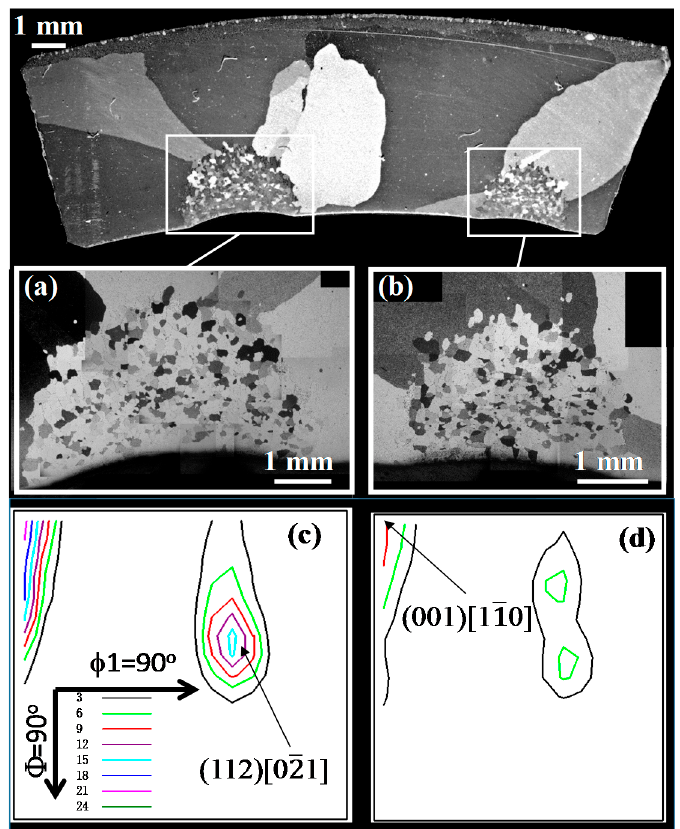
Figure 3. Recrystallized microstructure after annealing at 1350 °C for 3 h of the prior Brinell test areas with loads of ( a ) 49 kN, and ( b ) 29.5 kN, and the corresponding texture before recrystallization in ( c ) the indented and ( d ) non-indented areas.